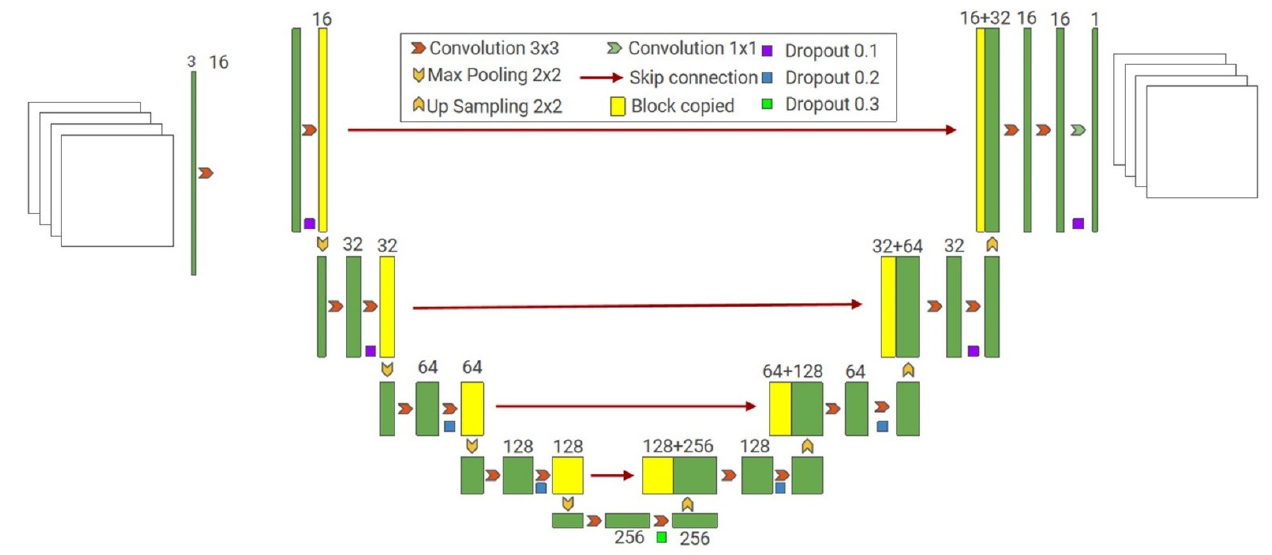
Figure 4. U-Net architecture.